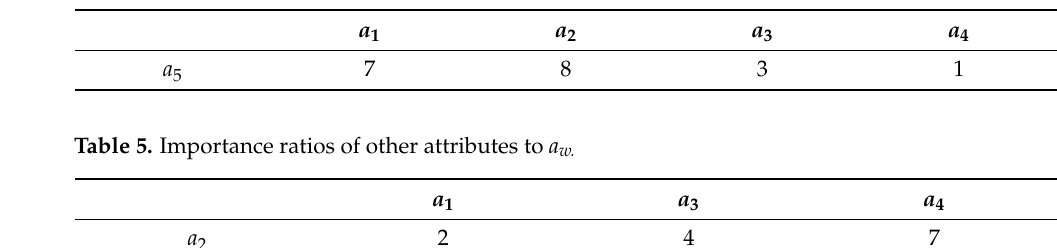
Table 4. Importance ratios of a b to other attributes.